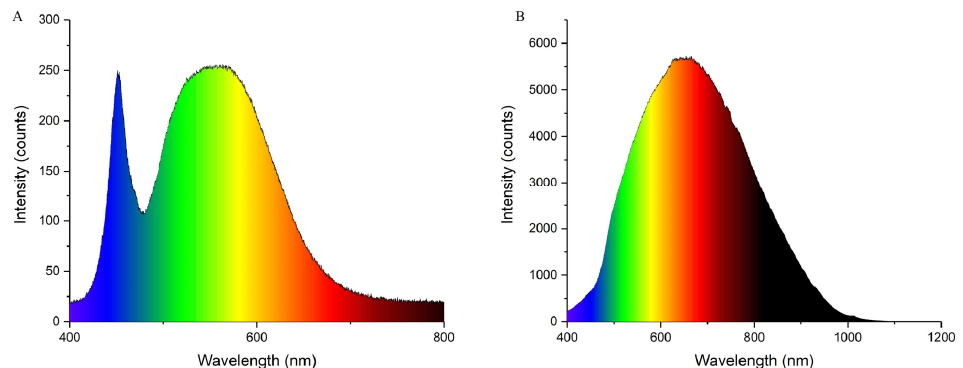
Figure 13. Spectral qualities of the supplementary light sources. ( A ) White LEDs (L) and ( B ) incan- descent lamp (In).